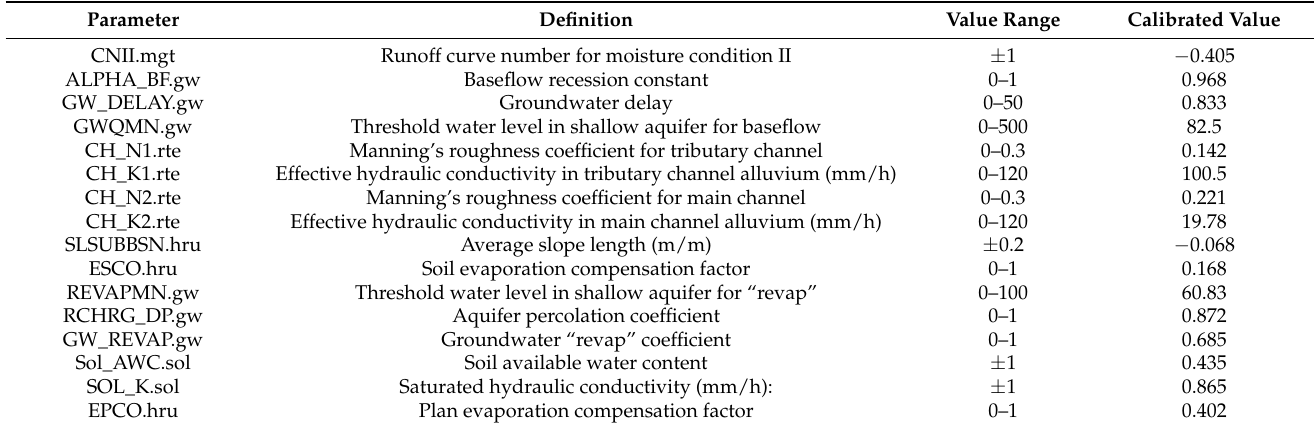
Table 1. Value ranges and calibrated values identified by SWAT-CUP for the Joumine reservoir